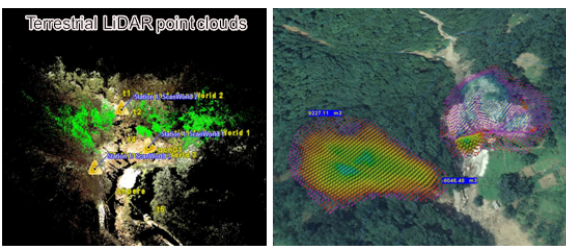
Figure 8. LiDAR point clouds (left) and volume analysis in study area (right)